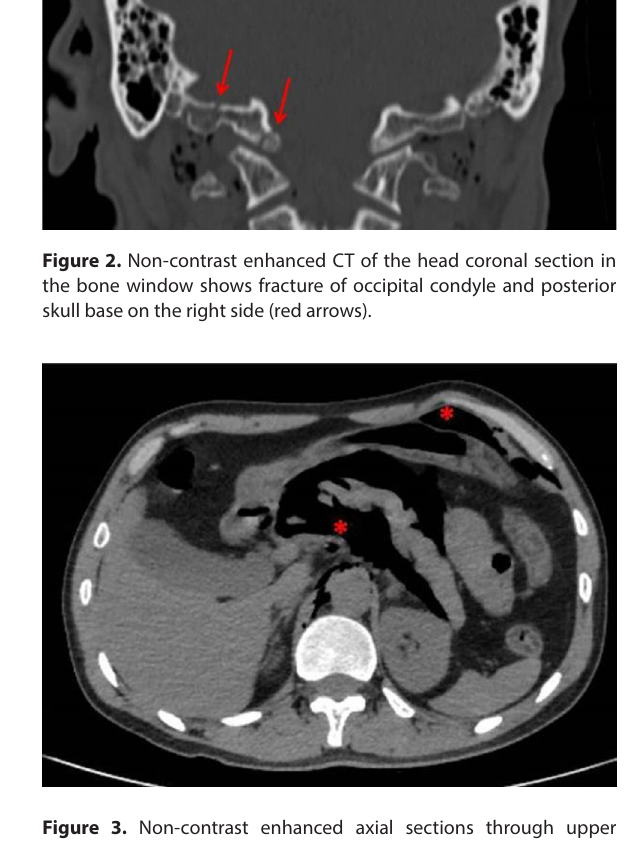
Figure 3. Non-contrast enhanced axial sections through upper abdomen shows significant air collection around pancreas suggestive of pneumoretroperitoneum and within the peritoneal cavity